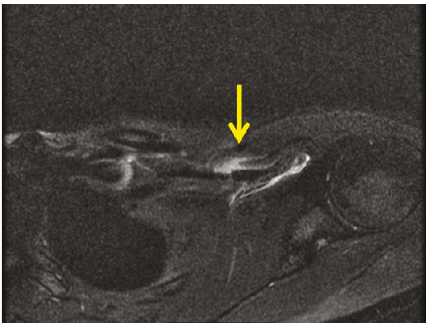
Figure 1: Axial T2-weighted magnetic resonance imaging showing disruption of the pectoralis minor myotendinous junction with surrounding edema and associated intramuscular